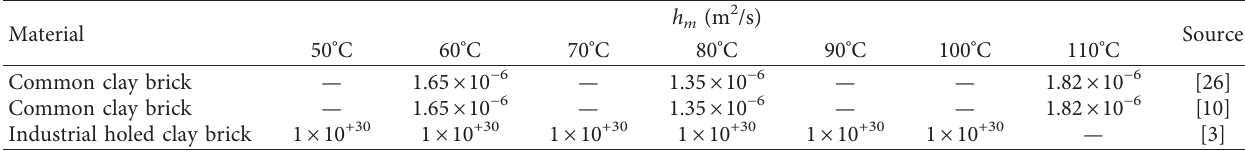
Table 10: Convective mass transfer coefficient of clay brick at different drying conditions as reported in the